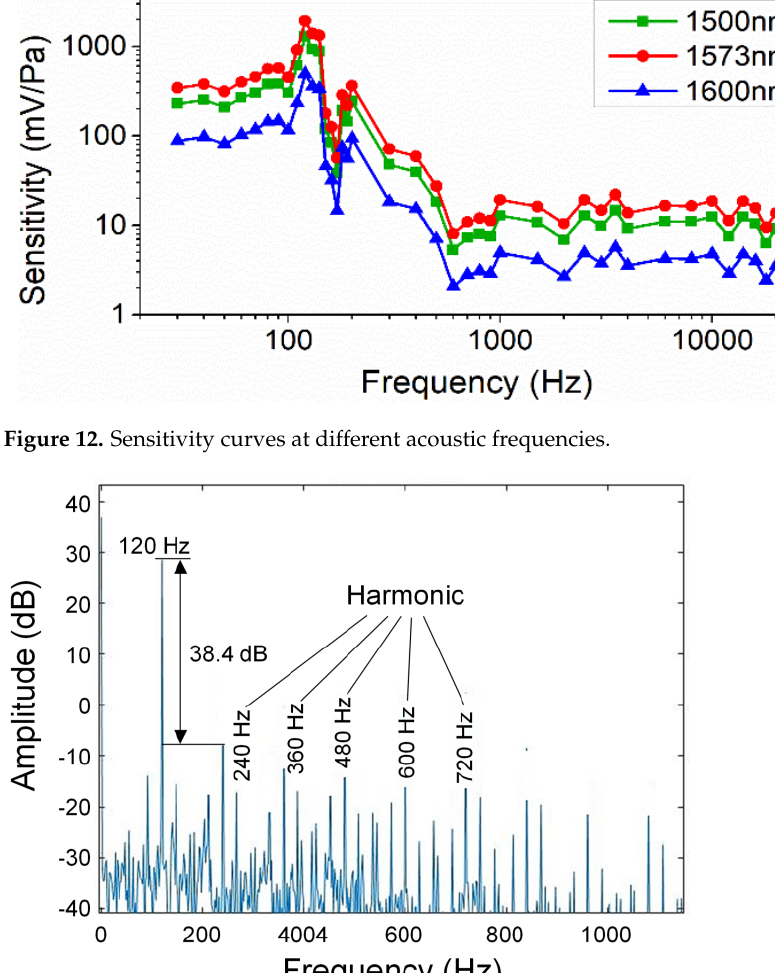
Figure 13. Frequency-domain diagram of the measured acoustic signal (operation wavelength: 1573 nm, acoustic wave frequency: 120 Hz).